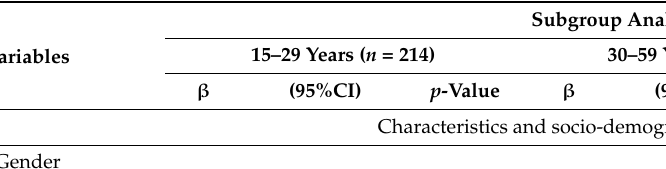
Table 4. Subgroup analysis by age groups of the factors associated with general health